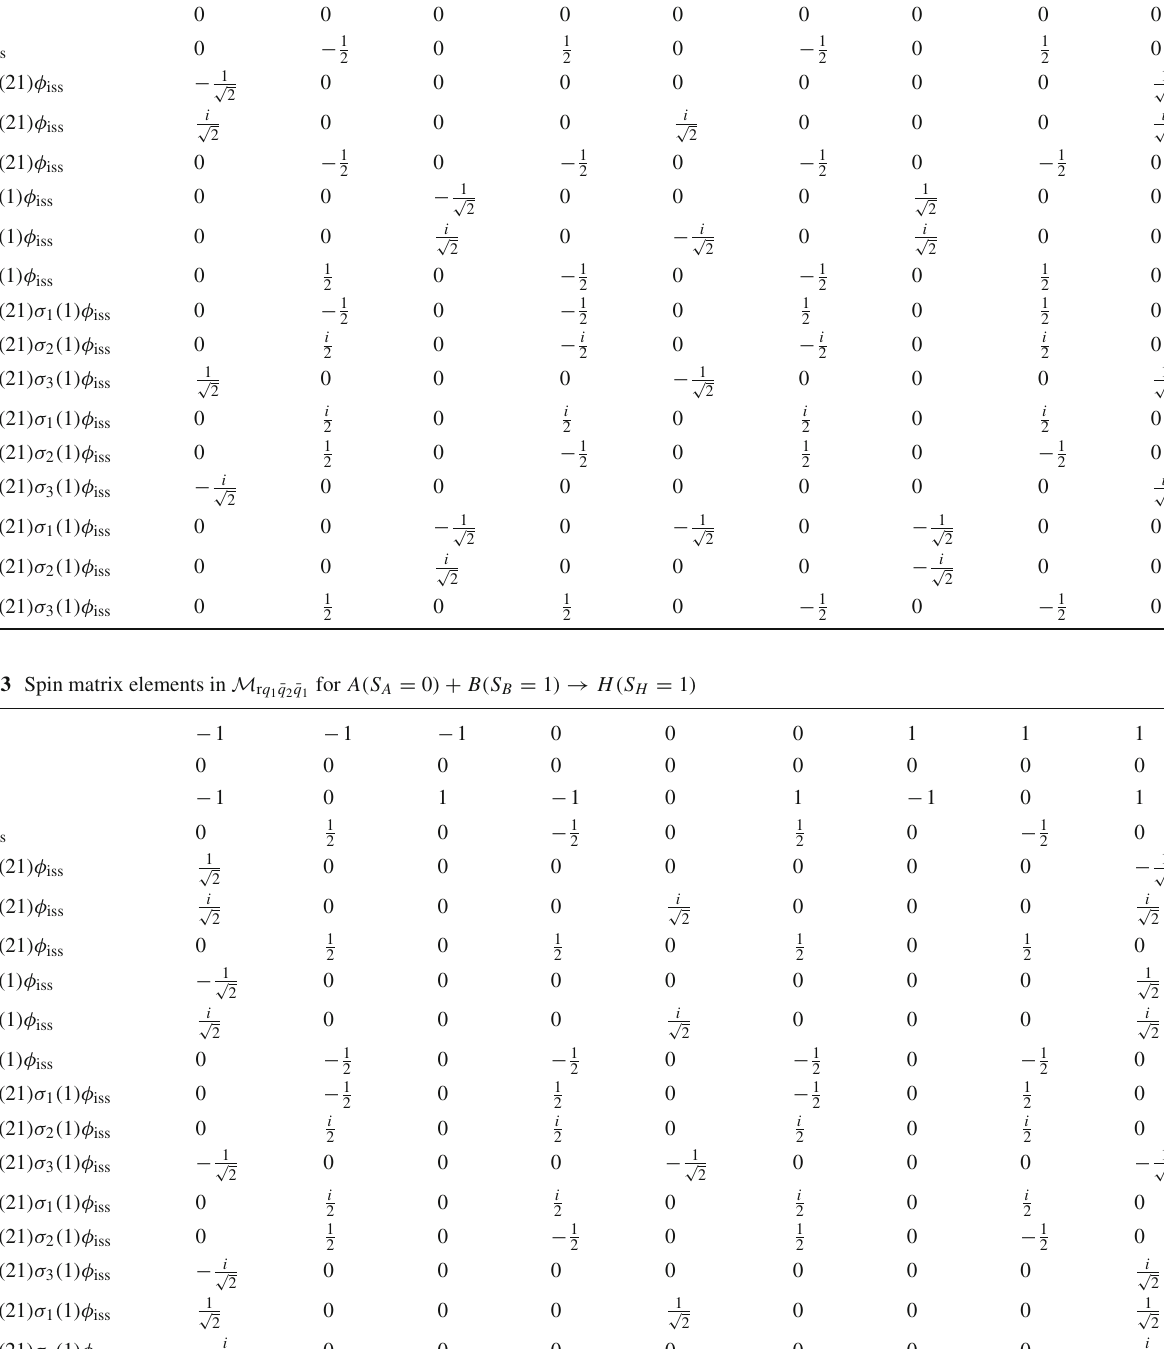
Table 2 Spin matrix elements in M r q